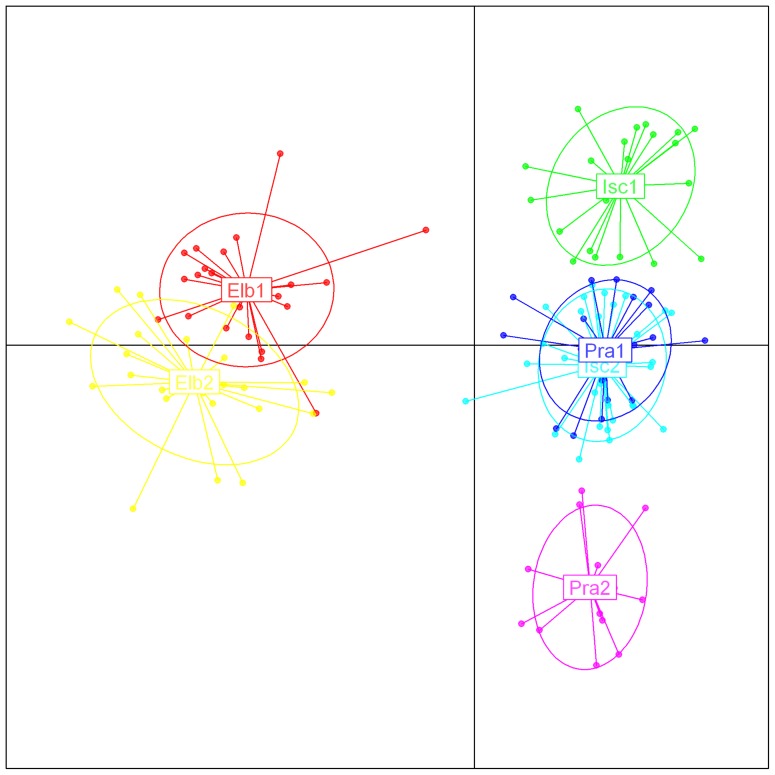
Subdivision of the red coral populations according to the DAPC method.Sampled populations are indicated with different colors, dots represent individual colonies.